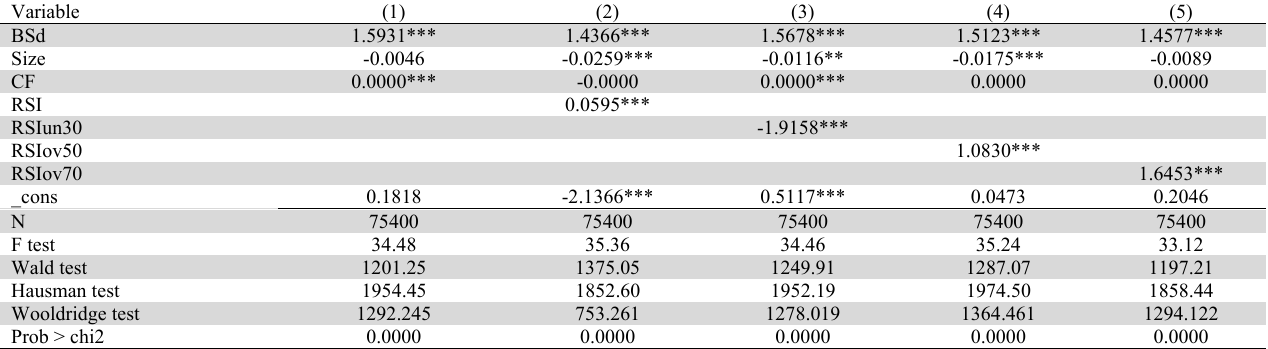
Regression results according to GLS